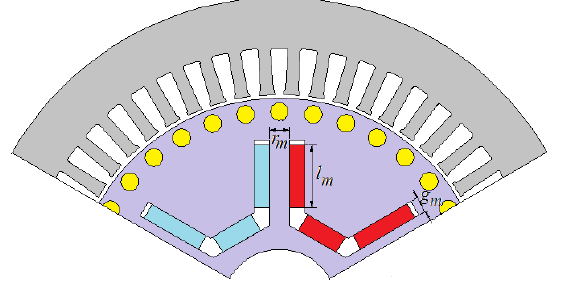
Fig. 2. The structure of LSPMSM.